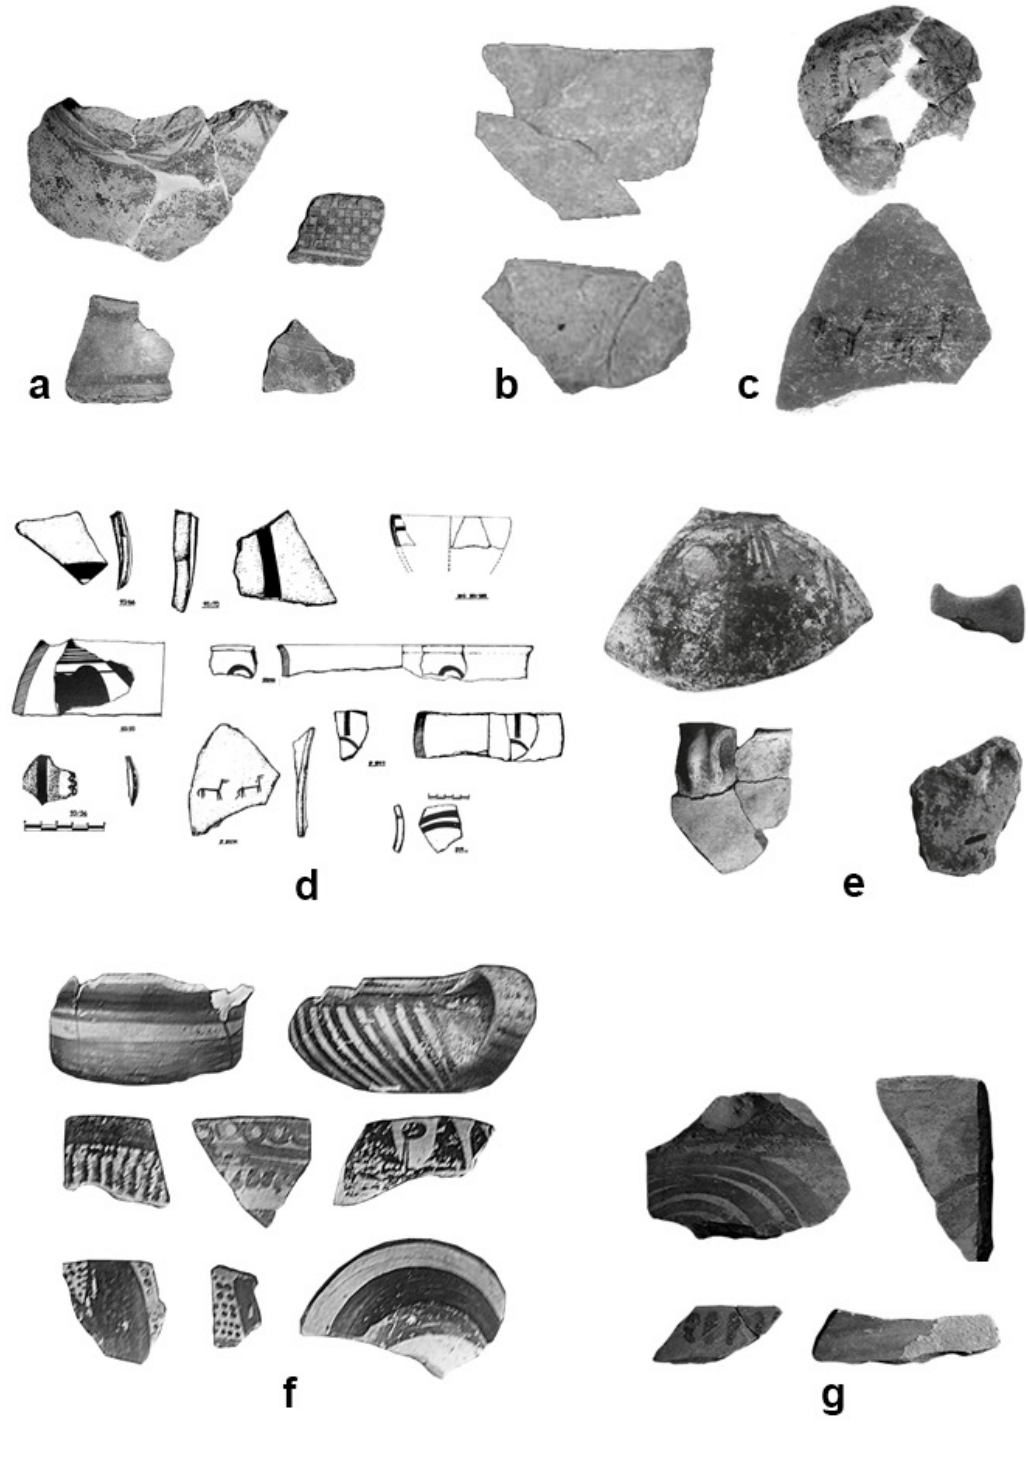
Figure 1: a) Middle Helladic and Late Helladic I–II pottery from Monte Grande (after Castellana, 2000); b) Canaanite type storage jar from Monte Grande (Marazzi, 2016); c) Coarse transport jars of Levantine type from Monte Grande (Marazzi, 2016); d) Late Helladic I–II and other Aegean type pottery from Monte Grande (after Castellana, 2000); e) Aegean and Levantine pottery from Mursia (Marazzi, 2016); f) Late Helladic I–II from Lipari (after Voza, 1985); g) Late Helladic I–II pottery from San Vincenzo di Stromboli (after Levi et al.,